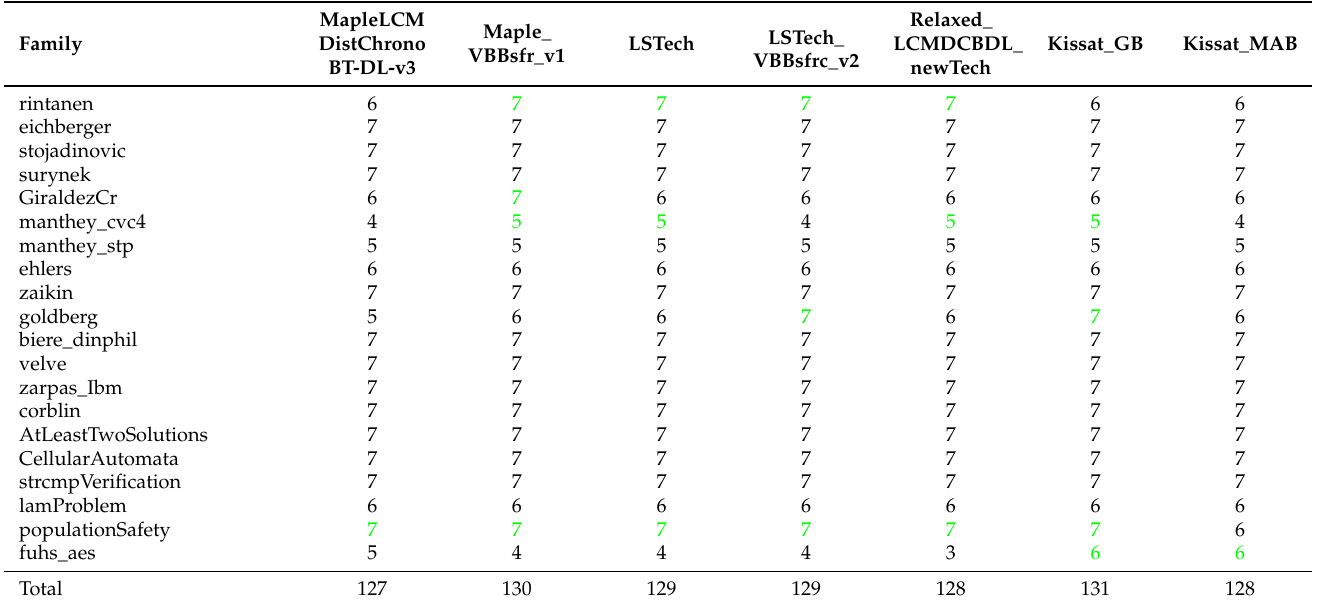
Table A7. The number of decided unsatisfiable instances of industrial families from the 2002–2021 SAT competitions. Each family consists of seven unsatisfiable